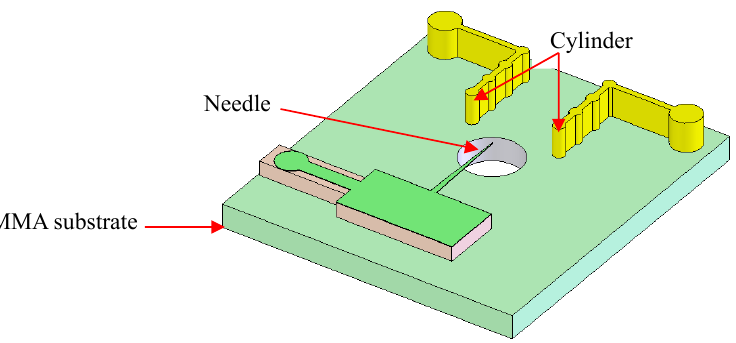
Figure 1. Schematic of the needle-to-cylinder micro ion source.